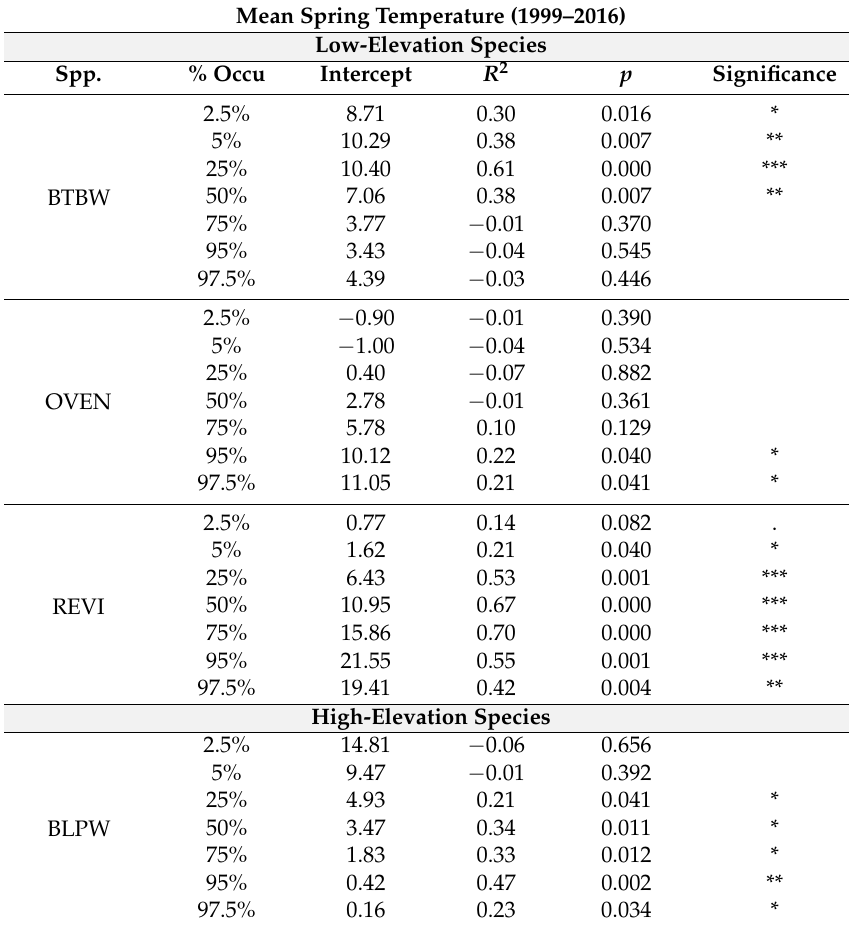
Table 1. HBEF songbird and small mammal species distribution shifts in relation to the mean spring temperature. The mean May temperature was used for all species, excluding BLPW, where the mean June temperature was used. Asterisks (*) denote statistically significant p -values (* p ≤ 0.05; ** p ≤ 0.01; *** p < 0.001). Periods (.) denote near significant p-values (0.05 < p ≤ 0.10). Abbreviations: Black-capped chickadee (BCCH), black-throated blue warbler (BTBW), hermit thrush (HETH), ovenbird (OVEN), red-eyed vireo (REVI), blackpoll warbler (BLPW), magnolia warbler (MAWA), dark-eyed junco (DEJU), Swainson’s thrush (SWTH), winter wren (WIWR), red squirrel (RESQ), and eastern chipmunk (EACH). Mean Spring Temperature